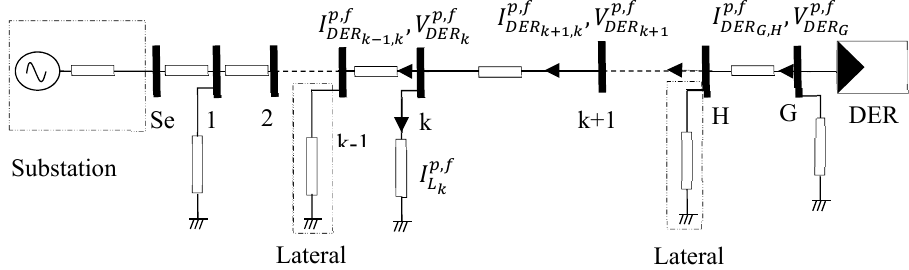
Figure 4. Estimation of the fault voltage and current phasor in all nodes of the Distributed Energy Resources’ (DER) radial.